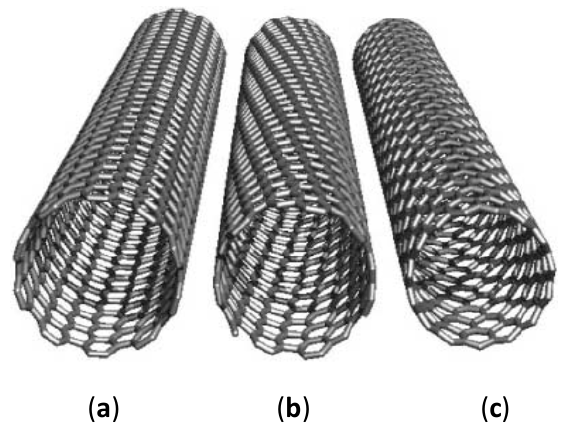
Figure 1. The idealized illustration of three distinctive SWCNTs with open ends. ( a ) an achiral metallic conductive armchair (10,10) SWCNT, ( b ) a chiral semi-conductive (12,7) SWCNT, ( c ) an achiral conductive zigzag (15,0) SWCNT. SWCNT in (c) is conductive as n (cid:3041)(cid:2879)(cid:3040) Copyright © 2002, John Wiley and sons.